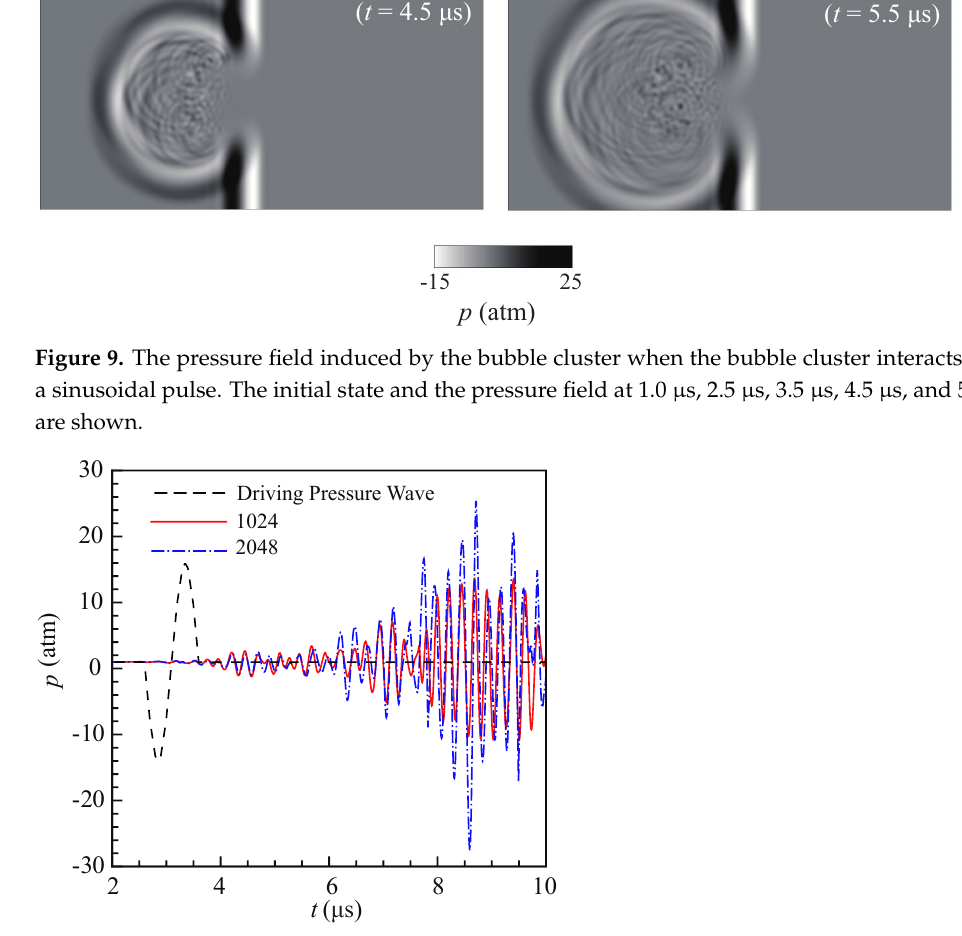
Figure 10. The time history of pressure at the bubble cloud center without (the dashed line) and with bubble cloud for two different